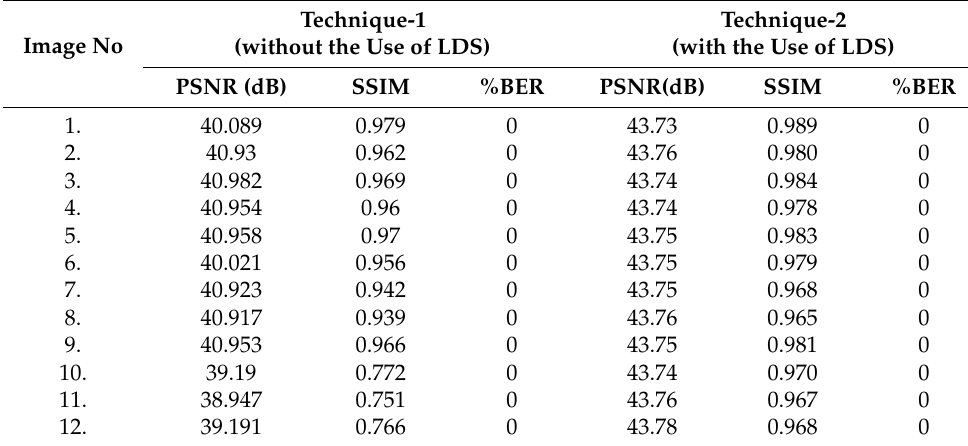
Table 1. Objective quality indices for Technique-1 and Technique-2.